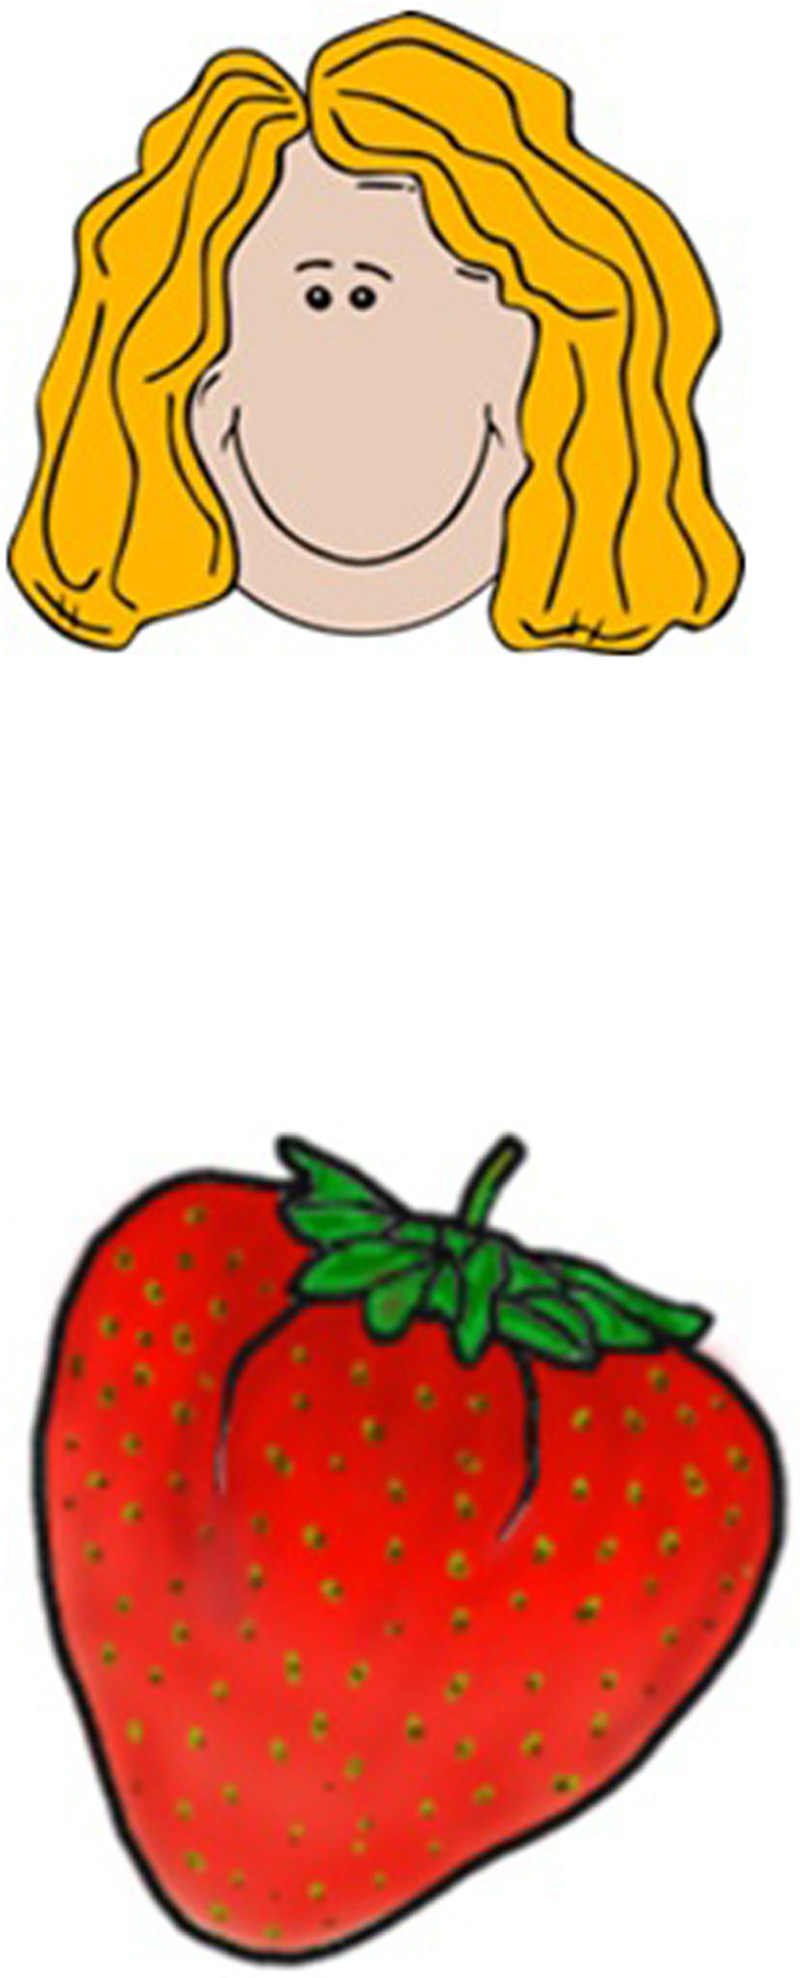
Example of a Dutch language trial on language switching task.